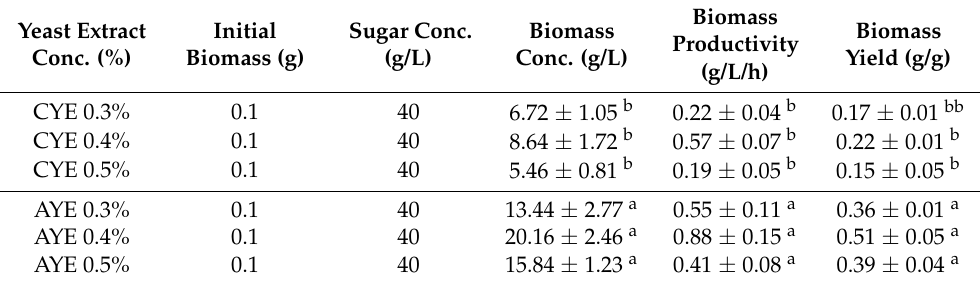
Table 4. Biomass productivity in fermentation using the S. cerevisiae AXAZ-1 strain after the addition of alternative yeast extract (AYE) and commercial yeast extract (CYE) in various